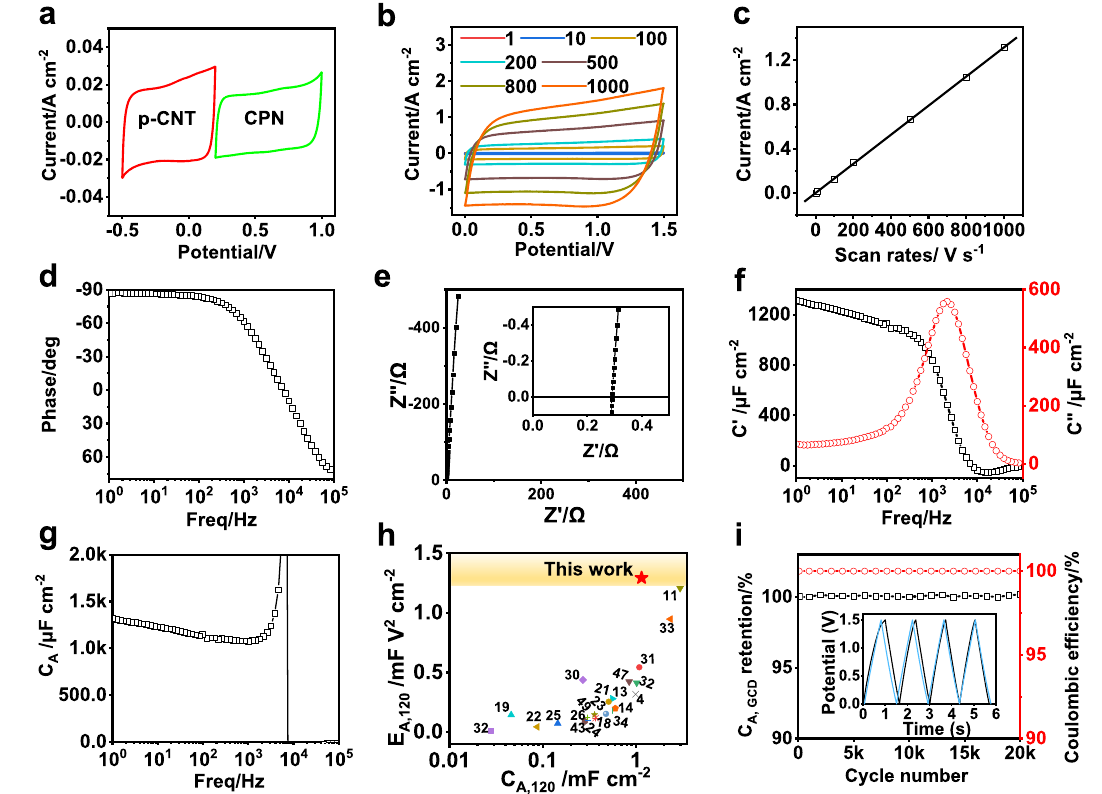
Fig.2|Theelectrochemicalperformanceofelectrodesandunit.a TheCVcurves of the positive CPN fi lm electrode and negative p-CNT fi lm electrode at the scan rate of 10Vs − 1 . b The CV curves of ACPEC at different scan rates from 1~1000Vs − 1 . c ScanratesversusdischargingcurrentdensityofACPEC. d – g Theelectrochemical impedance spectroscopy (EIS) test of an ACPEC unit. d) Bode plot. e Nyquist plot, inset:theexpandedviewathighfrequencies. f Plotsoftherealorimaginarypartsof speci fi ccapacitance( C ’ or C ” )versusfrequency. g Plotofareal-speci fi ccapacitance